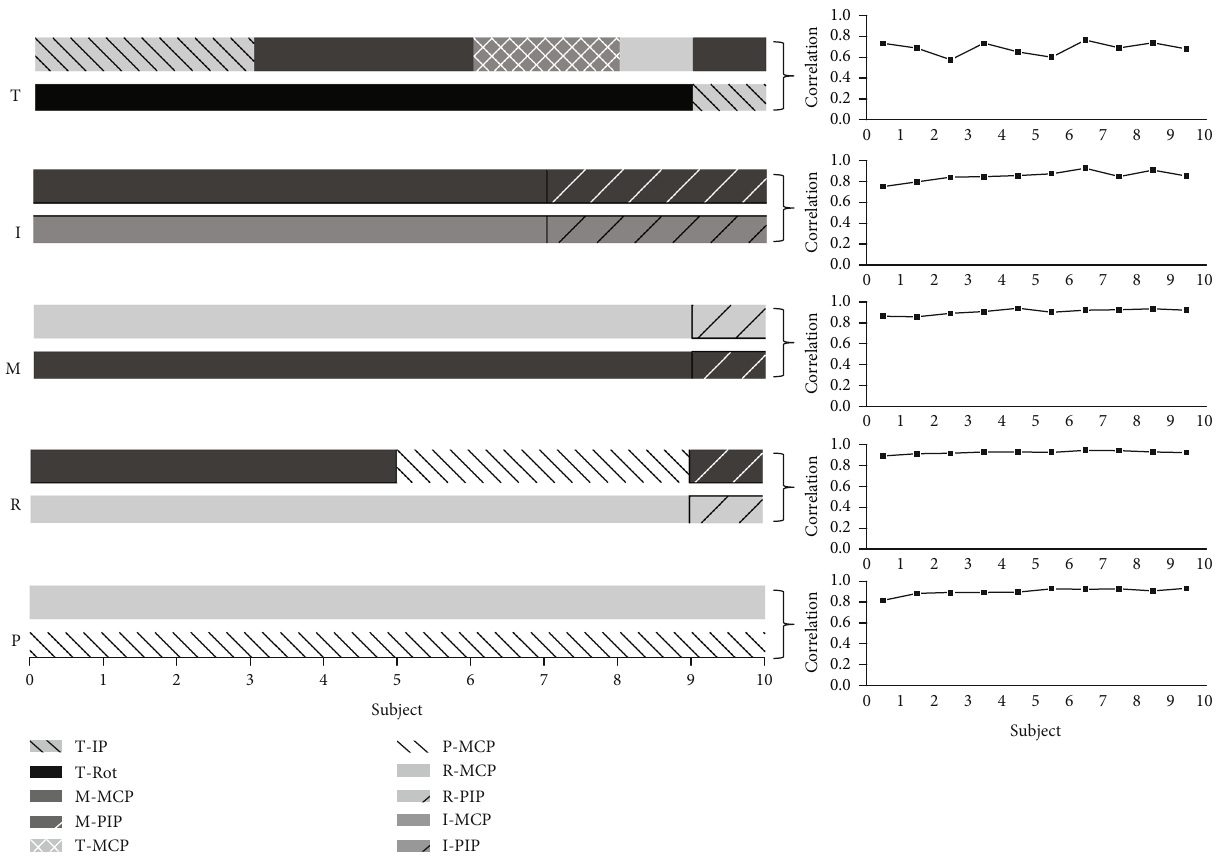
Figure 3: Paired joints with the highest correlation coe ffi cients in each fi nger for each subject and the highest correlation coe ffi cients in each fi nger across ten